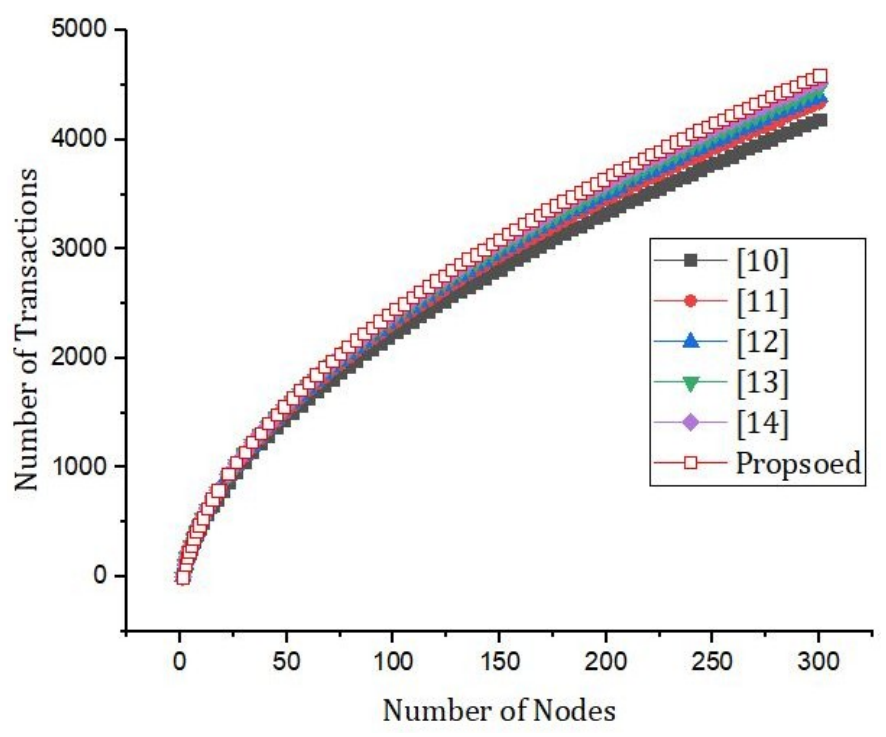
Figure 11. Simulation results based on the bandwidth and number of rounds.